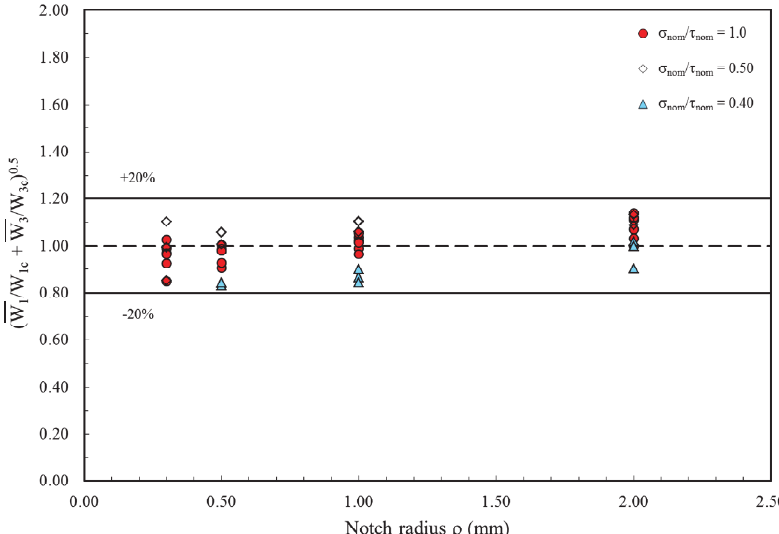
Figure 3: Synthesis of the results from combined tension and torsion tests based on the averaged